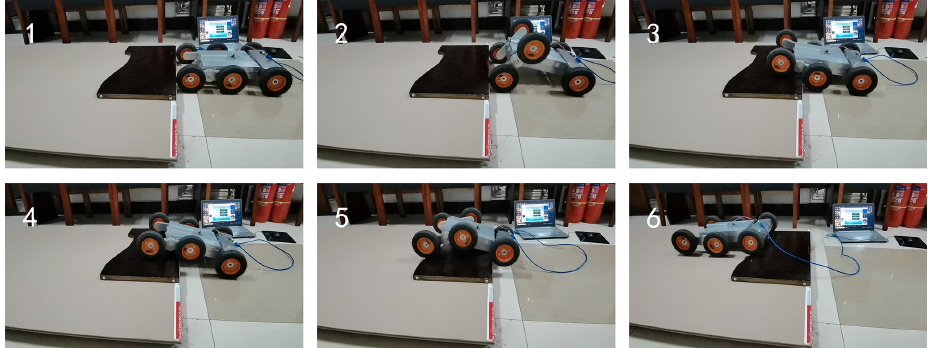
Figure 25. Experiment of the robot climbing 90mm vertical obstacle